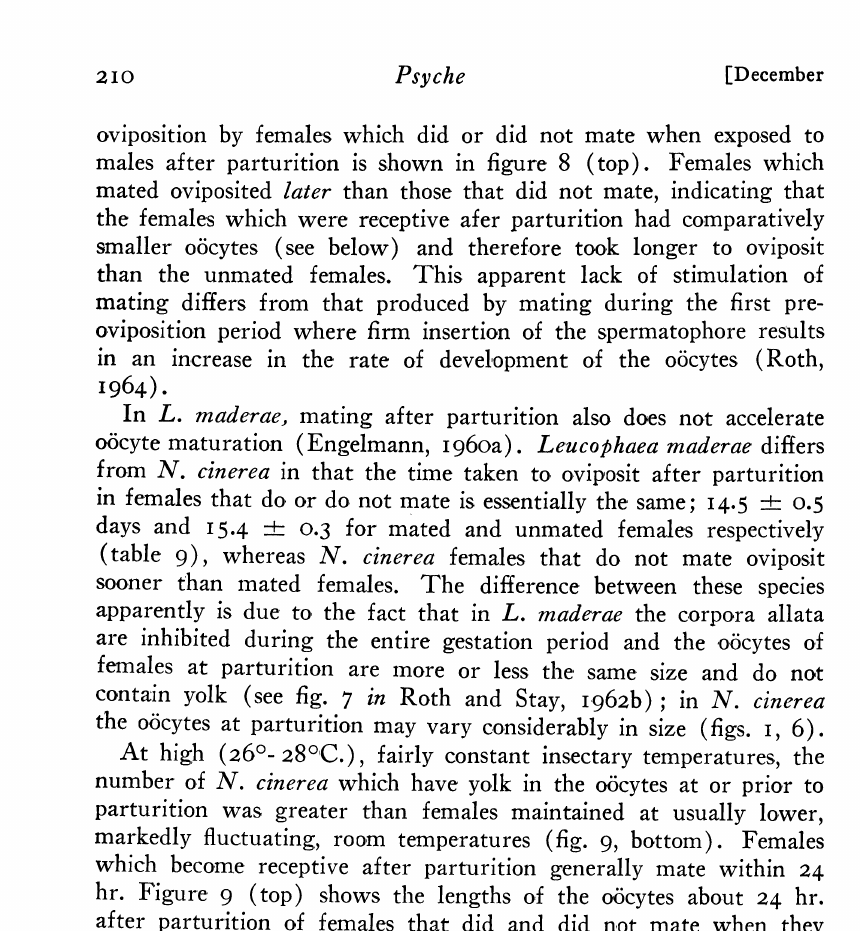
TABLE 2--Relationship between length of gestation period and receptivity following parturition in N.